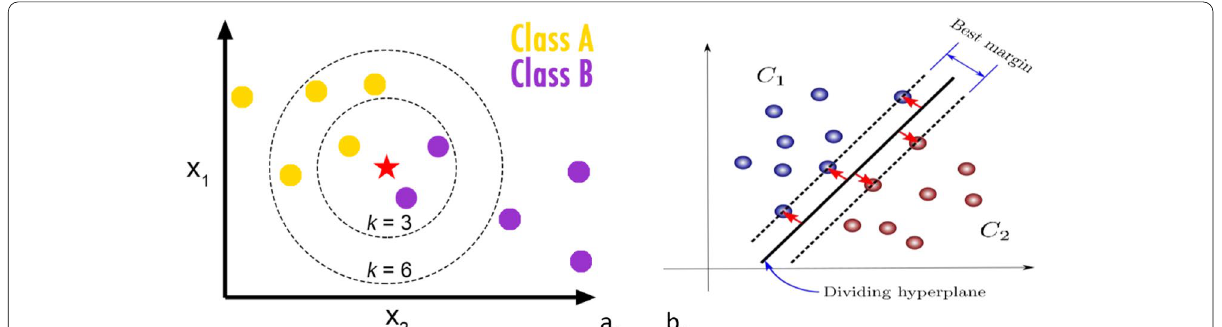
Fig. 3 Pictorial representation of a ) K‑Nearest neighbor classification on datapoints b ) SVM classification on datapoints in high dimensional vector